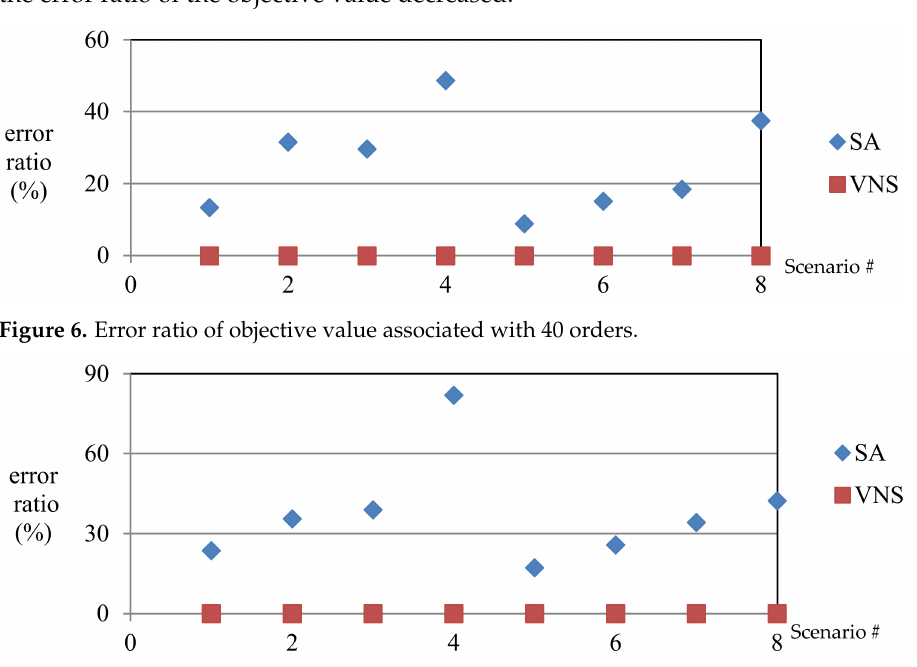
Figure 7. Error ratio of objective value associated with 80